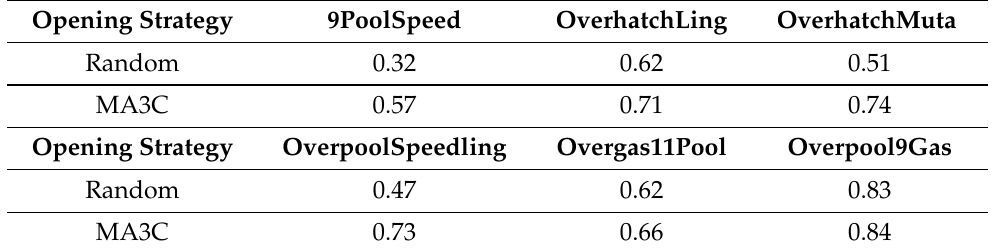
Table 3. The win rates of the trained RL agent against Steamhammer bots using different open- ing